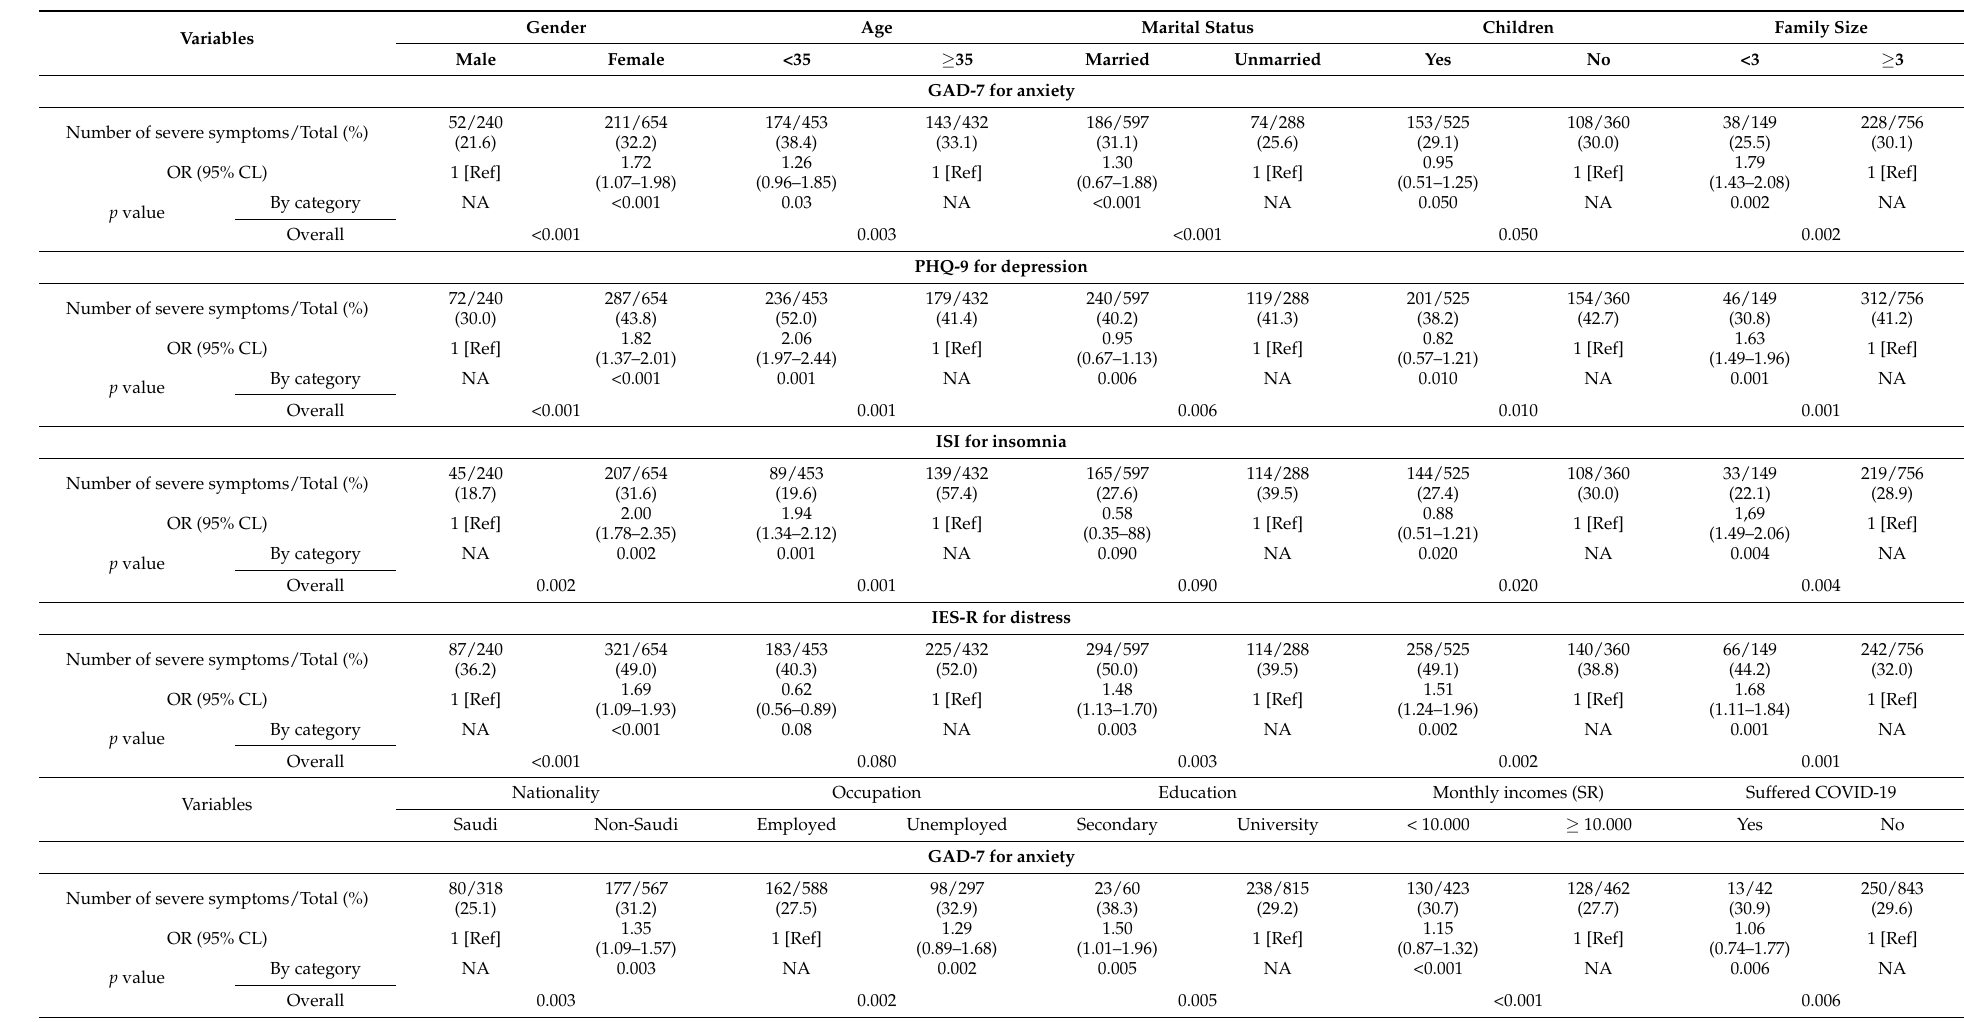
Table 4. Multivariable Logistic Regression Analysis to assess the probable risk factors of mental health